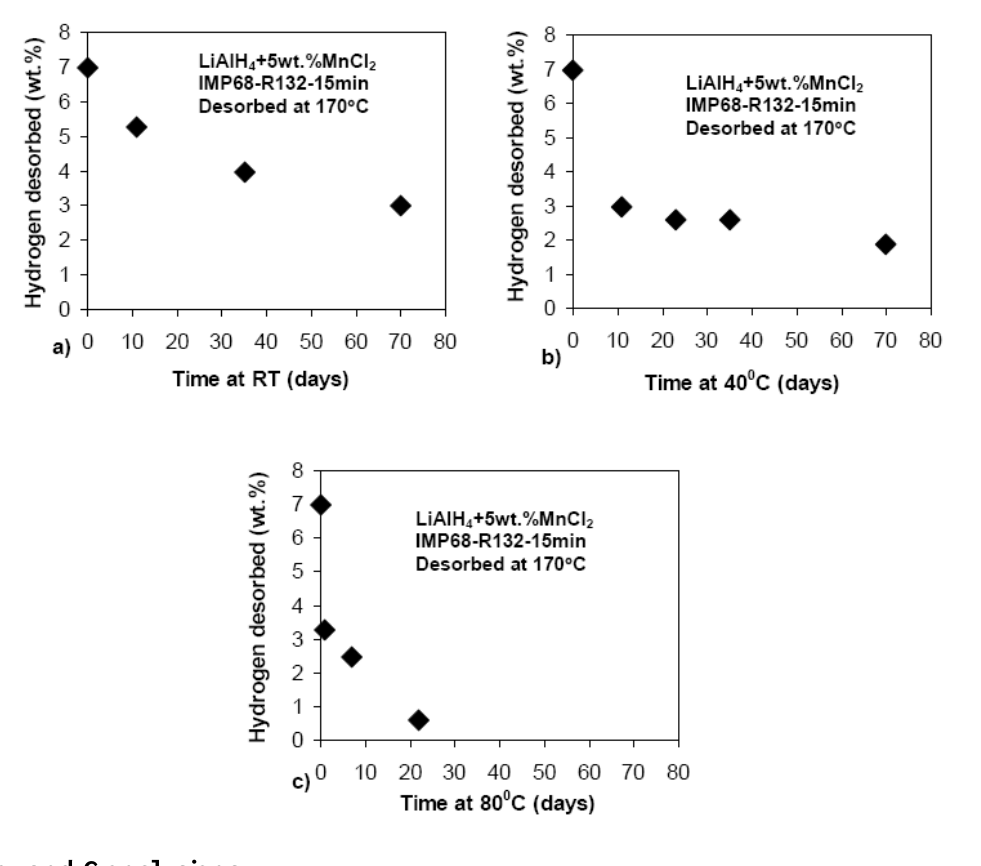
Figure 19. The amounts of hydrogen desorbed during long term storage at (a) room temperature (RT), (b) 40 and (c) 80 °C for ball milled LiAlH from